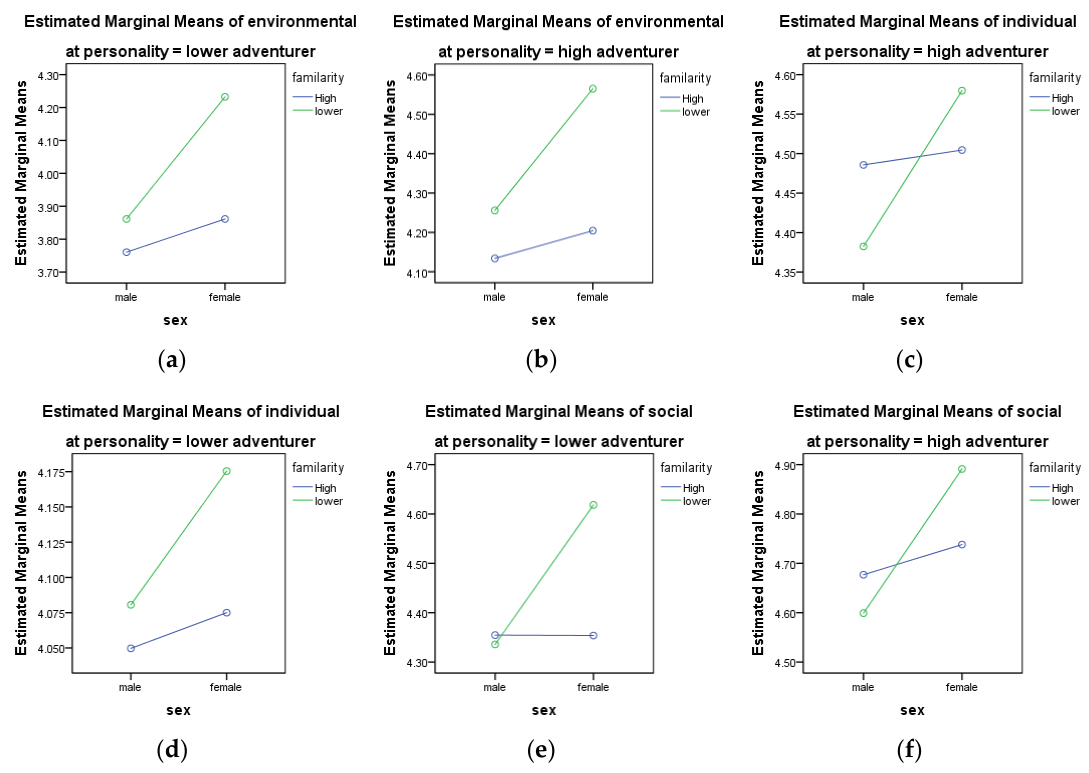
Figure 3. Interactive influence of personal traits and familiarity to walking experience.